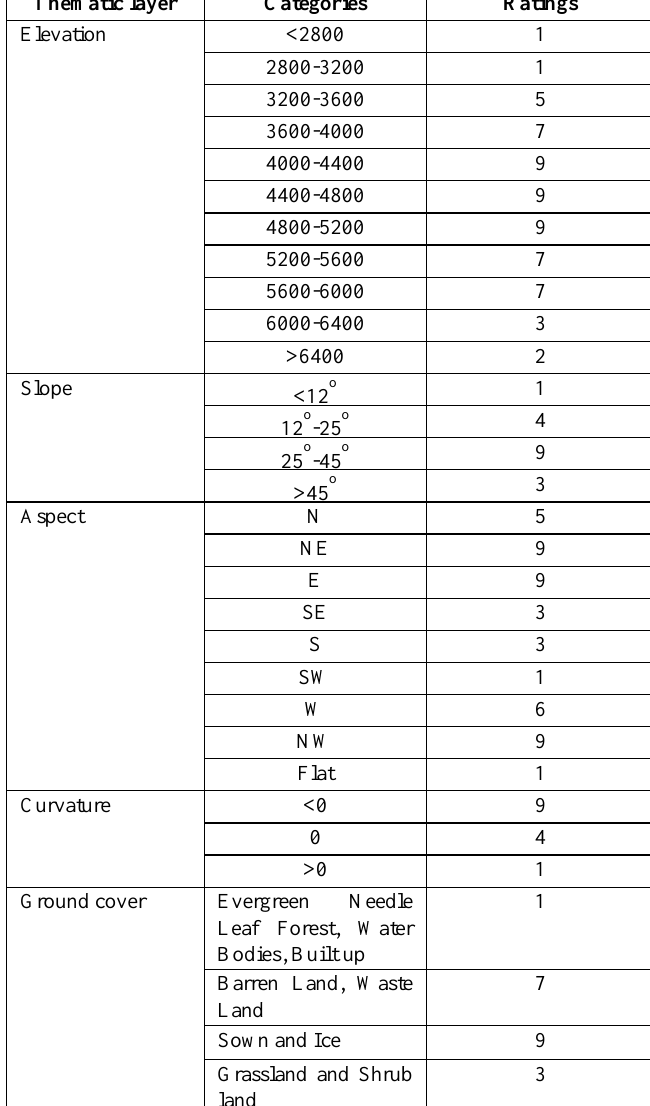
Table 2 Preference Descriptor (Saaty, 1990) Table 3 Ratings for terrain data layers and their